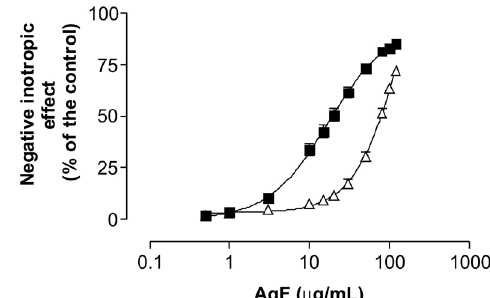
FIGURE 4 - Effect of TEA on the negative inotropic response of AqF in guinea pig left atria. Concentration-response curves were obtained on control (■, EC50 = 14.28 ± 3 m g/mL) and after adding 20 mM of TEA (Δ, EC50 = 50 ± 7 m g/mL) to the organ bath (27 ± 0.1 ºC, stimulation: 2 Hz, 400 V, 0.5 msec, n = 4, , Fcalc = 282.13; F(0.01; 21; 66) = 2.36; * p < 0.001).